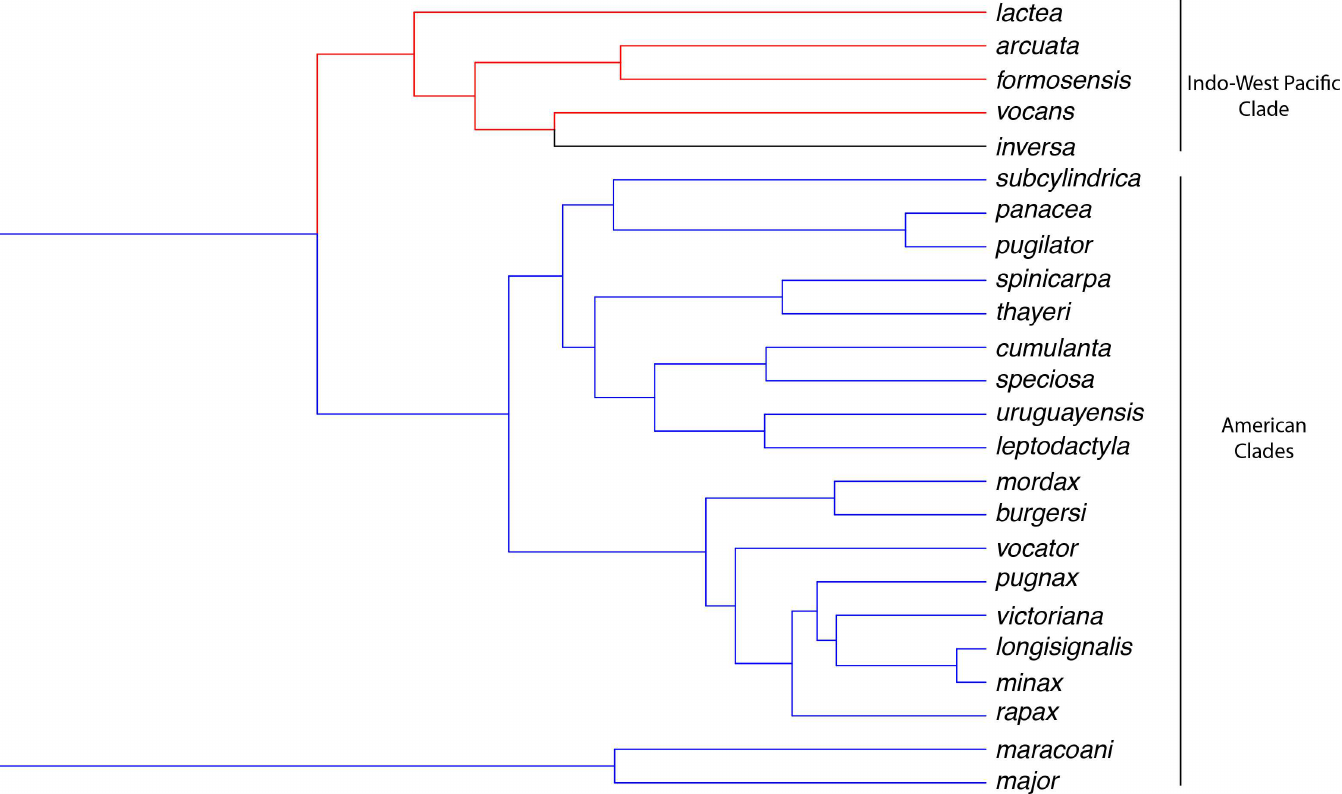
Fig 6. Evolutionary history of shifts in adaptive peaks of Uca osmoregulatory ability mapped onto the fiddler crab topology modified from Shih et al. (2015). Each color represents an optimum for all 9 osmoregulatory traits (see Table 1) analyzedtogether using SURFACE. The first peak (blue) was detected at the tree root and is shared by the Americanclades, i . e ., the subgenera Uca , Minuca and Leptuca .A second peak (red) occurs in the Indo-west Pacific species, with a shift in U . inversa (black), the last